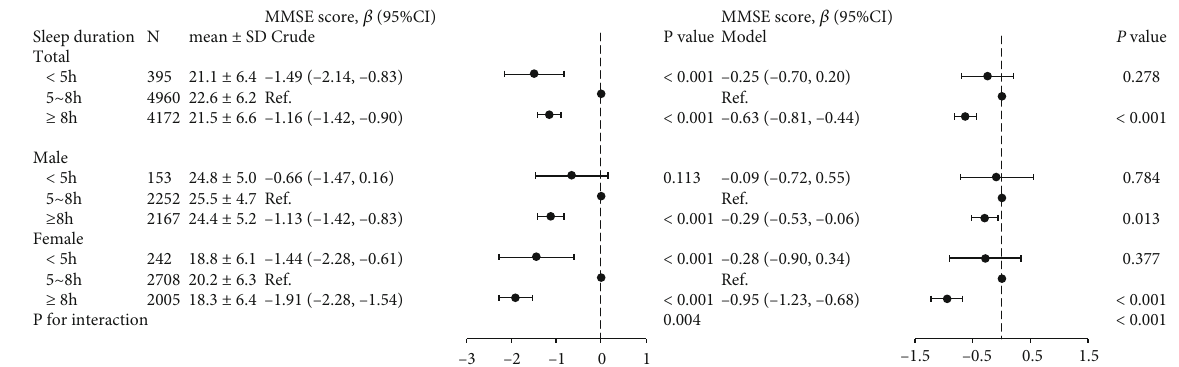
Figure 1: Sex di ff erences in the association between sleep duration and cognitive performance. CI: con fi dence interval; MMSE: Mini-Mental State Examination; BMI: body mass index; SBP: systolic blood pressure; DBP: diastolic blood pressure; Hcy: homocysteine; TG: triglycerides; HDL-C: high-density lipoprotein cholesterol; LDL-C: low-density lipoprotein cholesterol; eGFR: estimated glomerular fi ltration rate. P for interaction: 2-way interaction of sleep duration and sex on cognitive performance. The multivariate model adjusted for sex, age, education, physical activity, current smoking, current drinking, BMI, SBP, DBP, coronary heart disease, diabetes, antihypertensive drugs, antidiabetic drugs, statin-lowering drugs, Hcy, TG, HDL-C, LDL-C, and eGFR, except for the variable that was strati fi